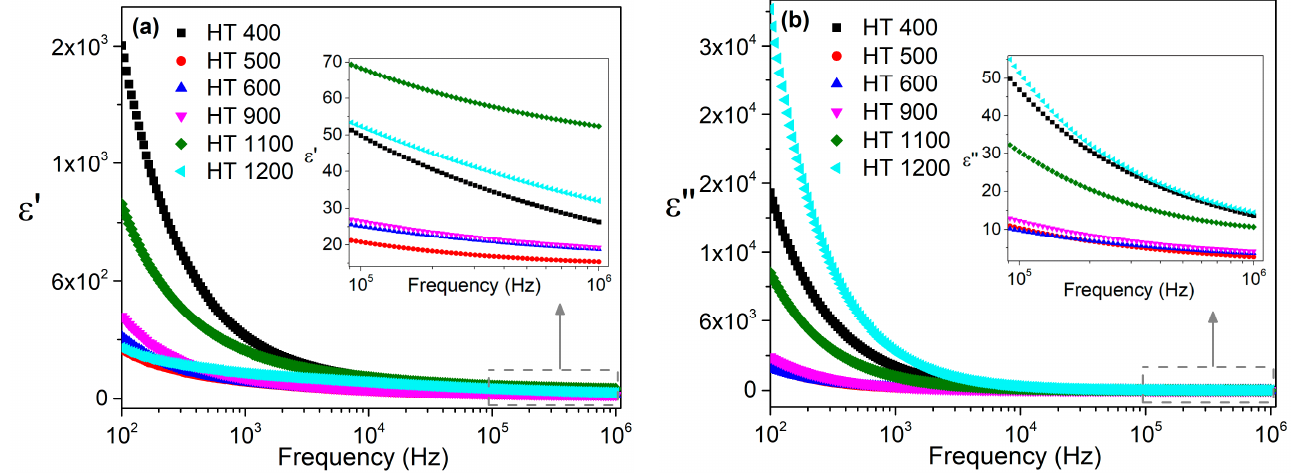
Figure 11. Frequency dependence of the ( a ) dielectric constants and ( b ) dielectric losses at room temperature for the samples prepared via the polymeric gel method.